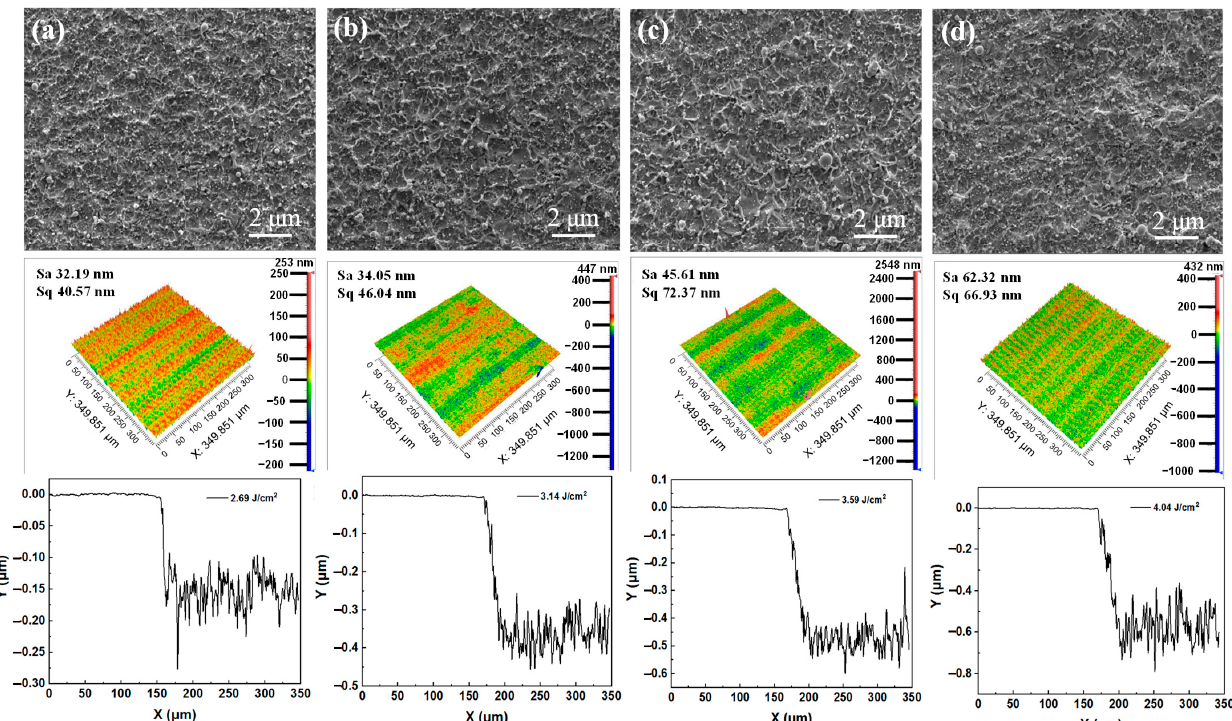
Figure 3. Surface morphologies and 3D morphologies of Cu films ablated by the ps − lasers at different laser fluences: ( a ) 2.69 J/cm 2 , ( b ) 3.14 J/cm 2 , ( c ) 3.59 J/cm 2 and ( d ) 4.04 J/cm 2 .